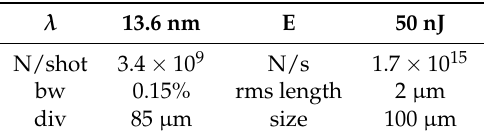
Table 4. Characteristics of the seed generated by the FEL oscillator at the entrance of the first modulator. Symbols are explained in Table